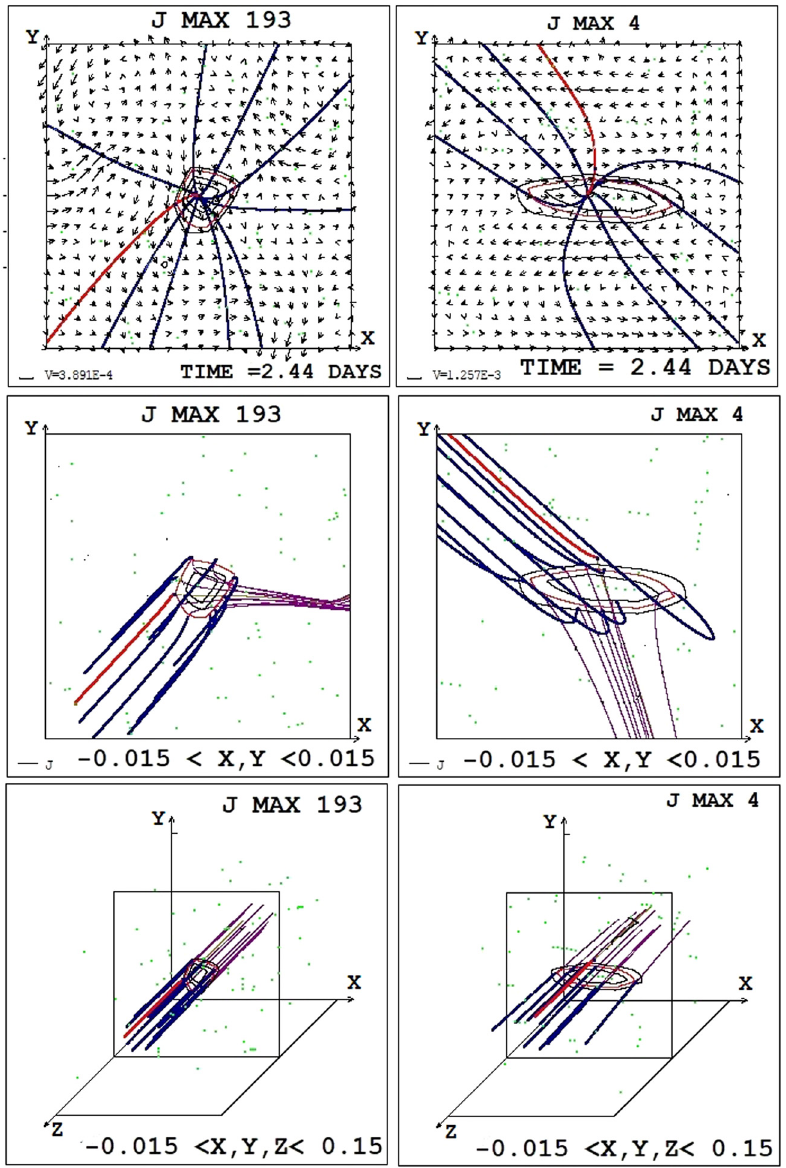
Figure 7: Magnetic fi eld con fi gurations and plasma fl ow near the 193rd and 4th current density maxima in the region with a linear size of 0.03 dimensionless units. Plane magnetic fi eld con fi gurations and plasma fl ows ( fi rst line of panels ) , projections of magnetic lines onto the plane of the con fi guration ( second line of panels ) , and 3D con fi gurations of the magnetic fi eld near the point of maximum current density ( third line of panels ) as in Figure